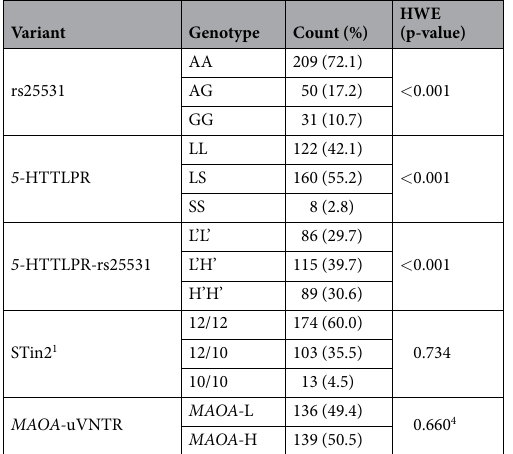
Table 1. Genotype counts and frequencies (%) of SLC6A4 and MAOA variants. P-values are from exact tests of Hardy-Weinberg equilibrium. Abbreviations: 5- HTTLPR: serotonin transporter-linked polymorphic region; MAOA: monoamine oxidase A; HWE: Hardy-Weinberg equilibrium. 1 Alleles are represented as repeats: 12 repeat = 301 bp (high expressing allele); 10 repeat = 267 bp (low-expressing allele). 2 MAOA -L: MAOA - uVNTR low-expressing allele (2-repeat + 3-repeat alleles). 3 MAOA- H : MAOA- uVNTR high-expressing allele (4-repeat + 5-repeat alleles). 4 HWE was calculated based on ungrouped MAOA allele frequencies; individual frequencies are as follows: 291 bp (2-repeat) = 19 (6.9%), 321 bp (3-repeat) = 117 (42.5%), 351 bp